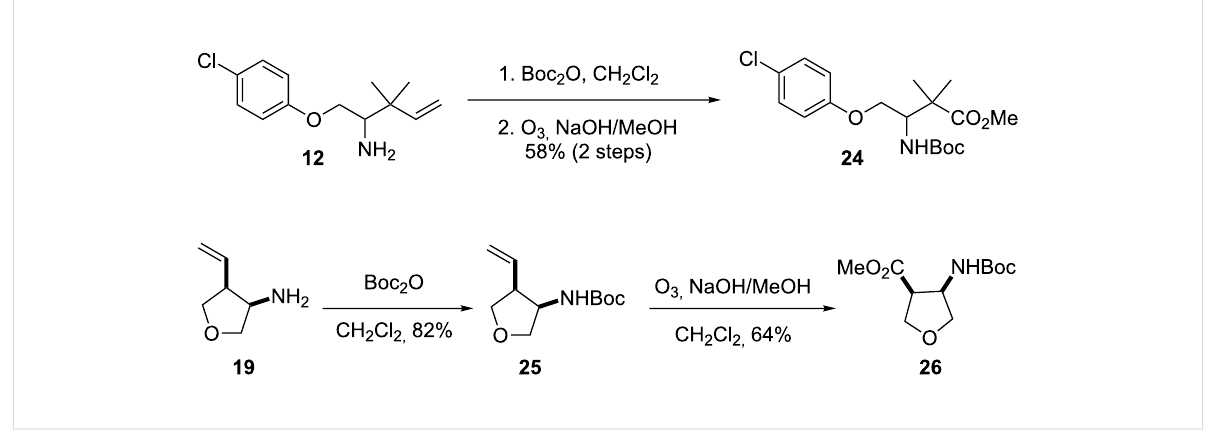
Scheme 4: Conversion of homoallylic amines to β -amino acid derivatives.